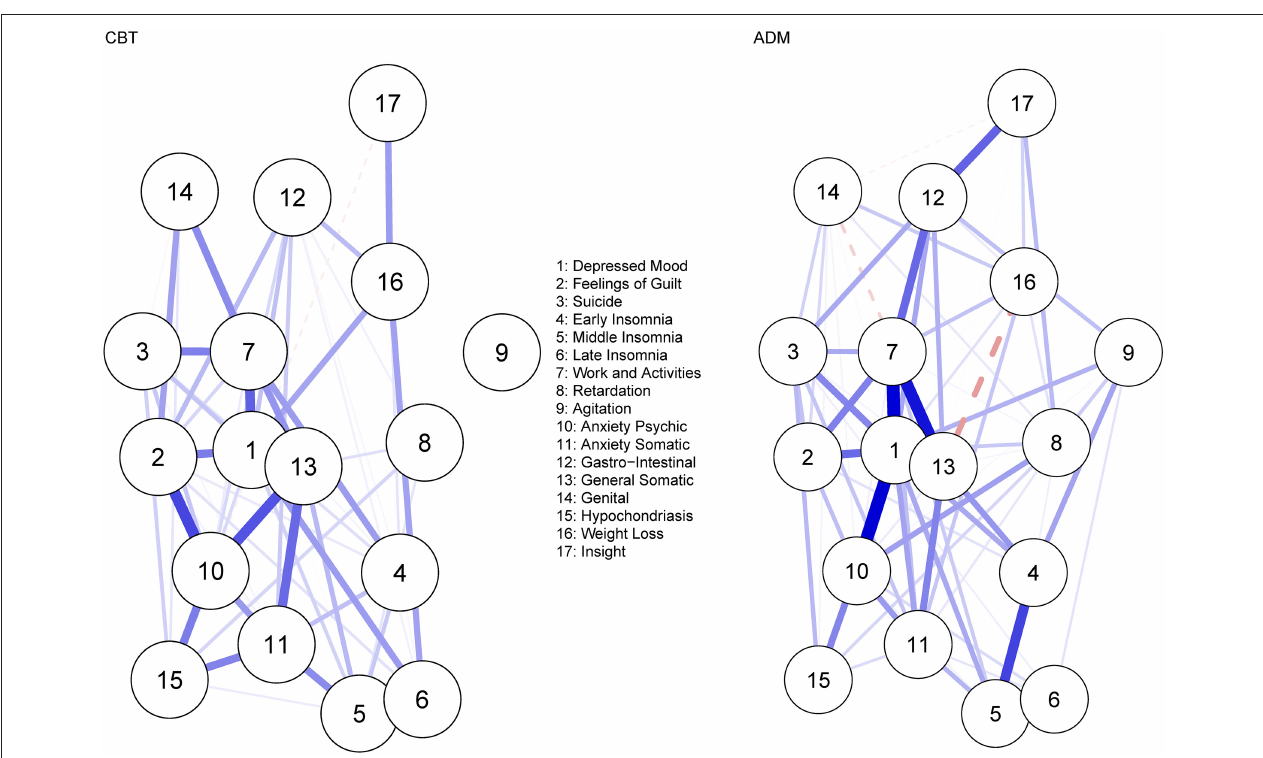
FIGURE 3 | Residual symptom network post-CBT and ADM’s, measured using the HDRS-17. Blue edges indicate symptom activation and red edges indicate symptom